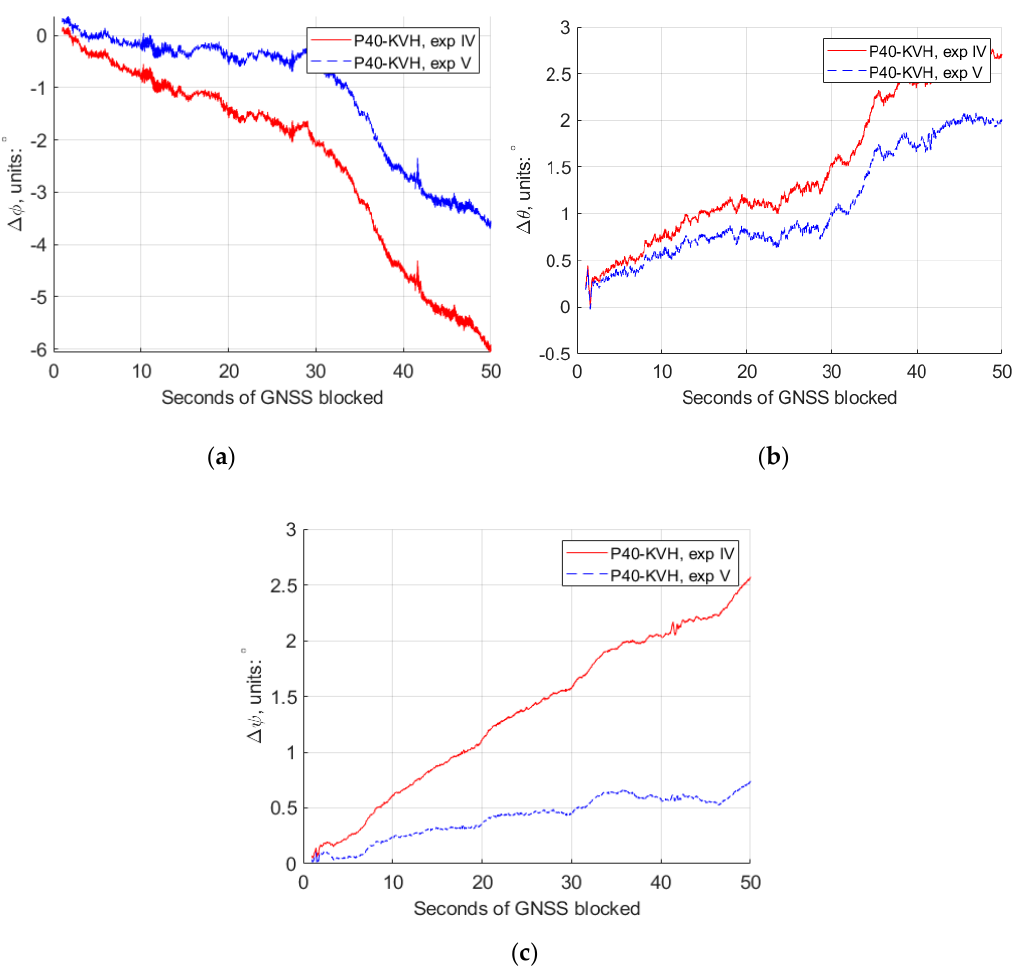
Figure 10. The roll, pitch and yaw attitude differences between GNSS/IMU-P40 (our program in a 15- state Kalman filter) and GNSS/KVH coupled navigation (IE software), with the conventional Kalman filter (experiment IV) and the modified Kalman filter (experiment V). ( a ) Roll differences; ( b ) pitch differences; ( c ) yaw differences.